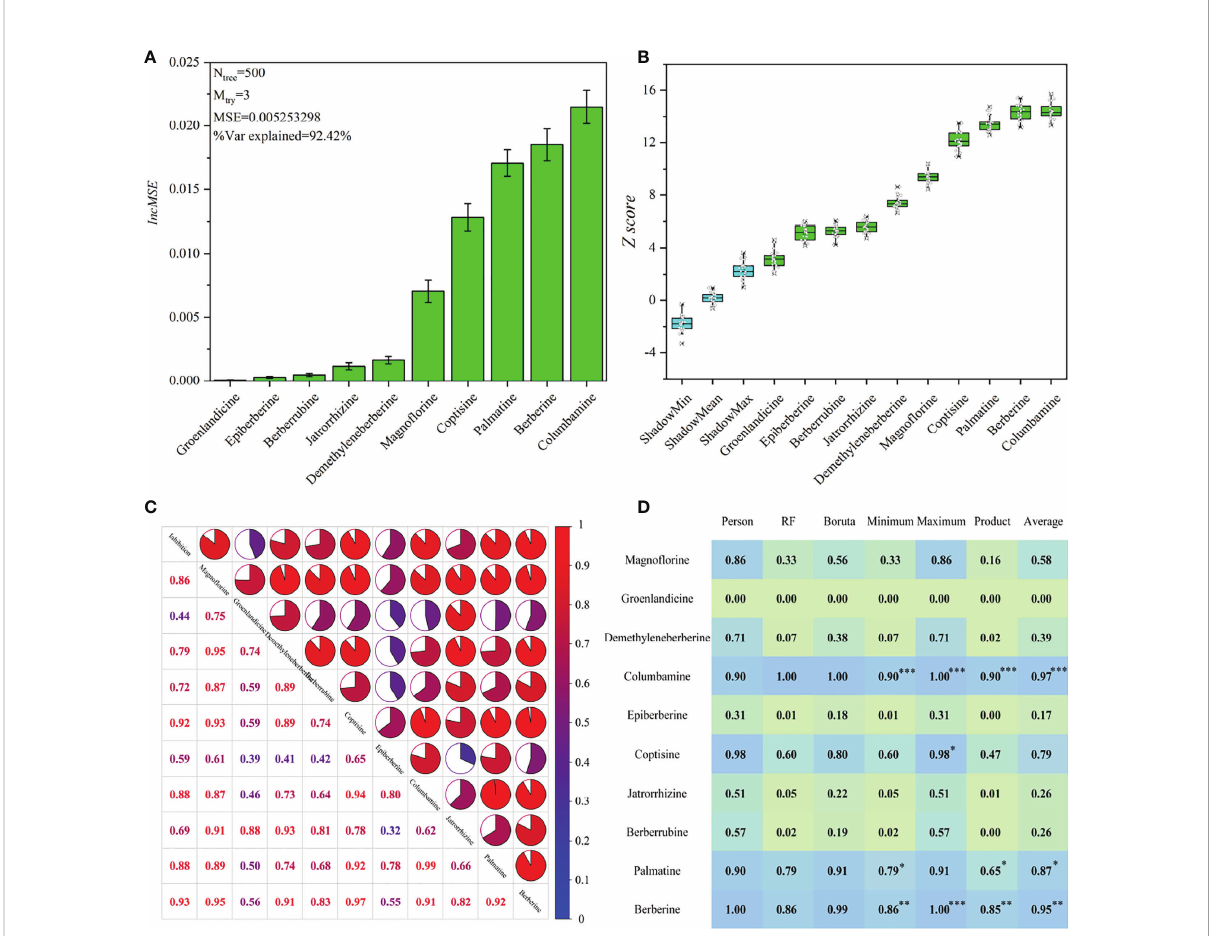
FIGURE 5 The results of spectrum-effect relationship based on different data processing methods. (A) the ranking result based on RF model; (B) the ranking result based on Boruta model; (C) the result of Pearson correlation analysis; (D) data fusion results, and ***, ** and * mean the fi rst, second and third ranking of these components, respectively.